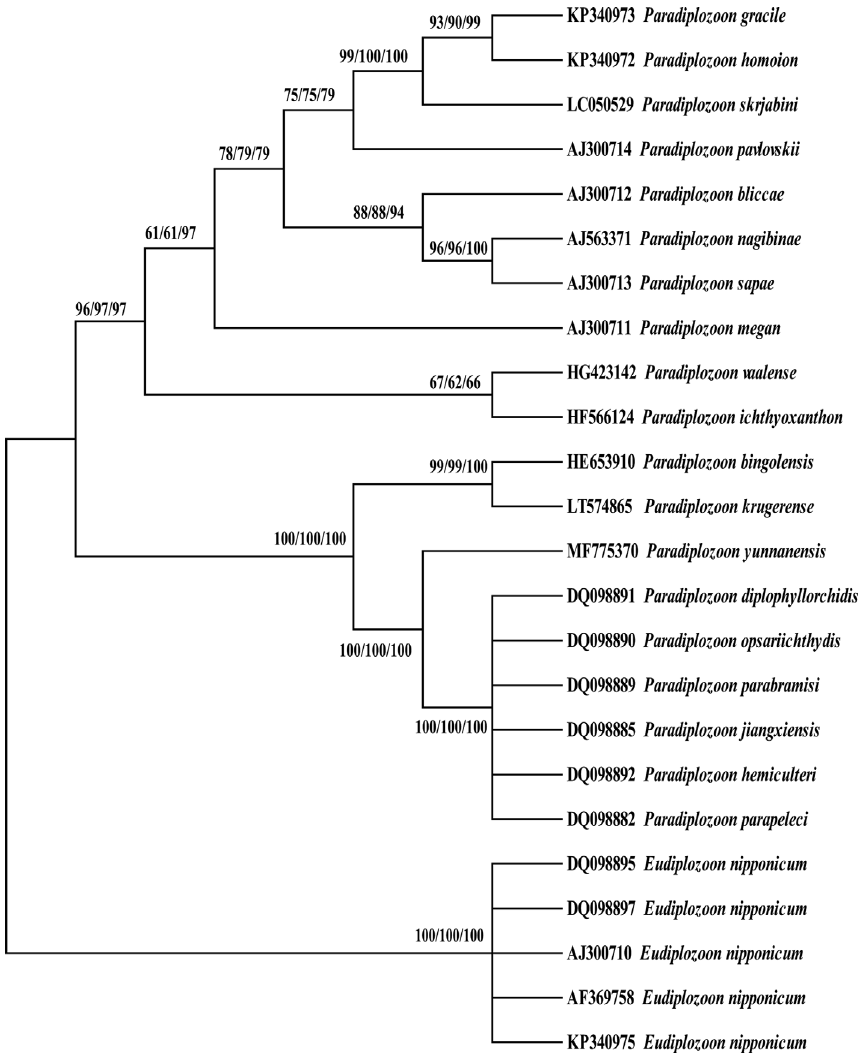
Figure 4. The rooted condensed tree (with 50% cut-off value) based on the NJ/ML/MP analysis